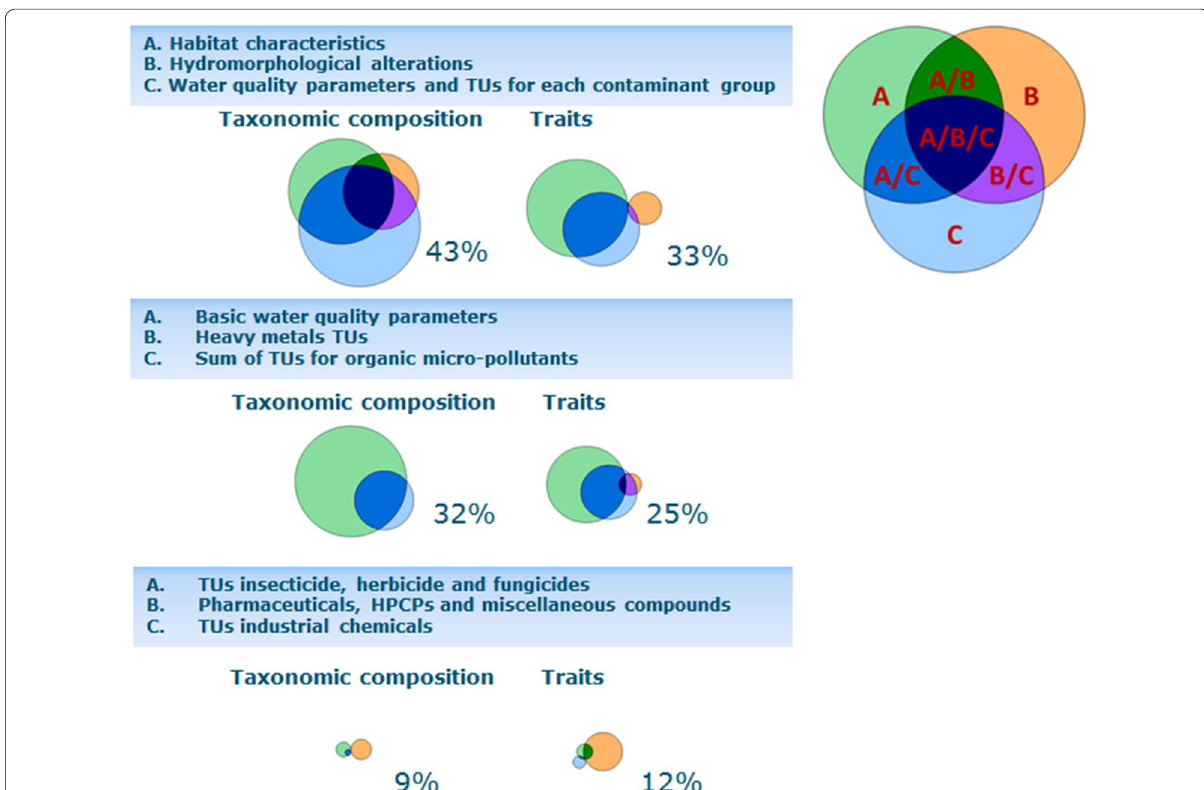
Fig. 4 Results of the variation partitioning analyses from three consecutive analyses (panels from top to bottom) for data from the Joint Danube Survey 3. Environmental parameters were used as explanatory variables for biological outputs analyzed as taxonomic composition and as traits composition. Consecutive analyses grouped explanatory variables according to different levels of specificity (Adapted from Rico et al. [56], with reprint permission from the